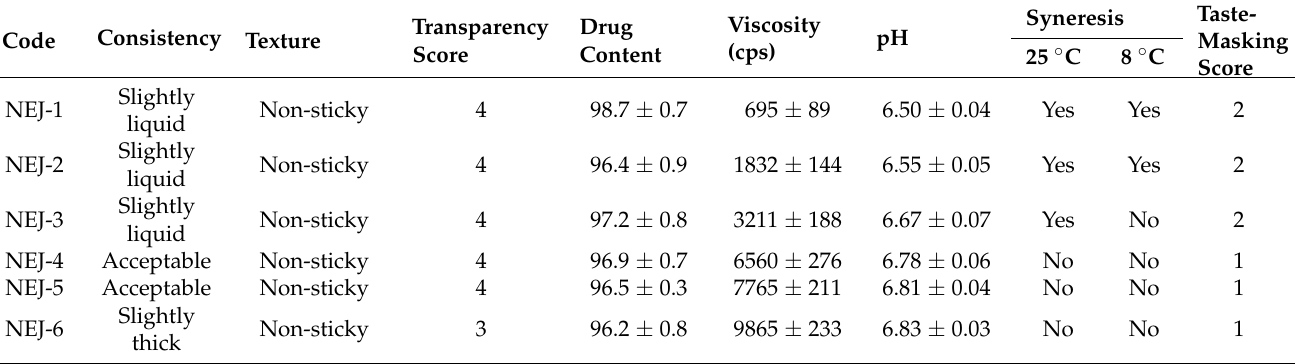
Table 8. Characteristics of tadalafil NE jellies